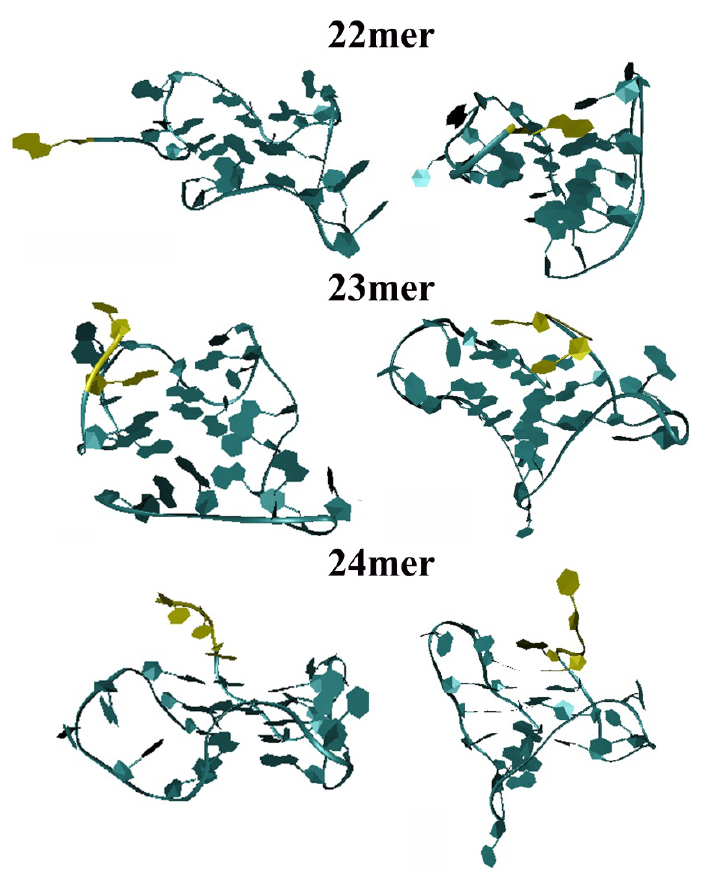
Figure 3. Images from molecular dynamic (MD) simulations (100 ps) of the parent 22-mer, the 5'-T (23-mer) and 5'-TT (24-mer) overhangs sequences based on Neidle’s crystal structure (left) and Patel’s solution structure (right). The positions of the 5'-A, 5'-TA and 5'-TTA overhang bases are shown in yellow while the remaining molecule is shown in